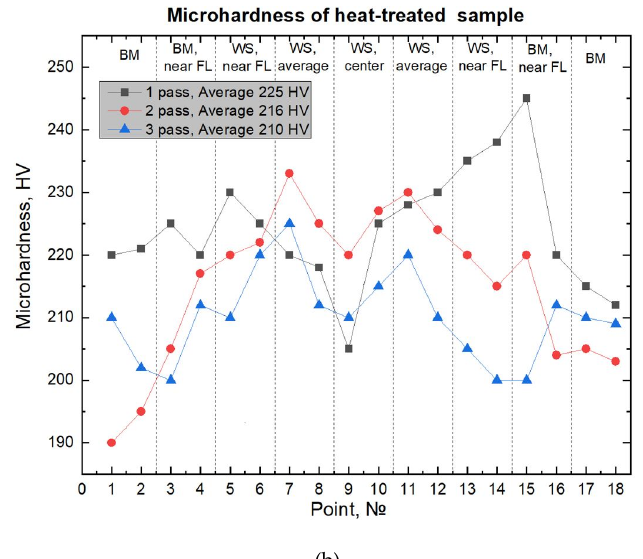
Figure 11. Microhardness of ( a ) NHT and ( b ) HT samples.